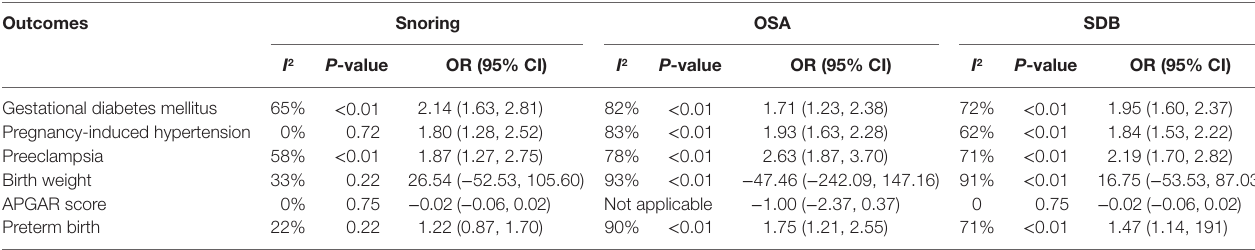
between different types of SDB (snoring or OSA). Overall, there